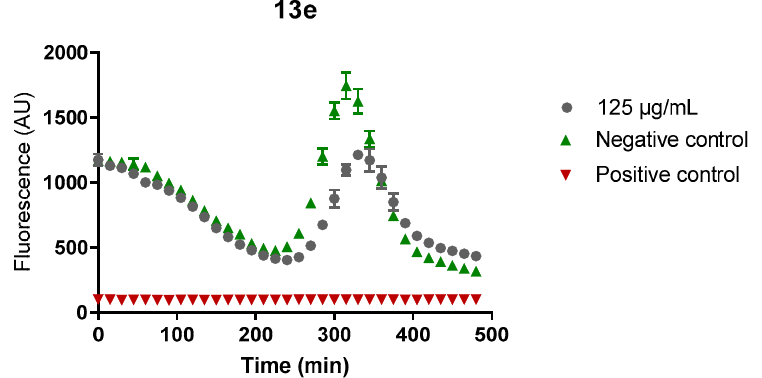
Figure 6. PQS inhibition by compound 13e using PAO1 pqsA:gfp reporter-based assay. Table 1. PQS inhibition by synthesized compounds using PAO1 pqsA:gfp reporter-based assay.